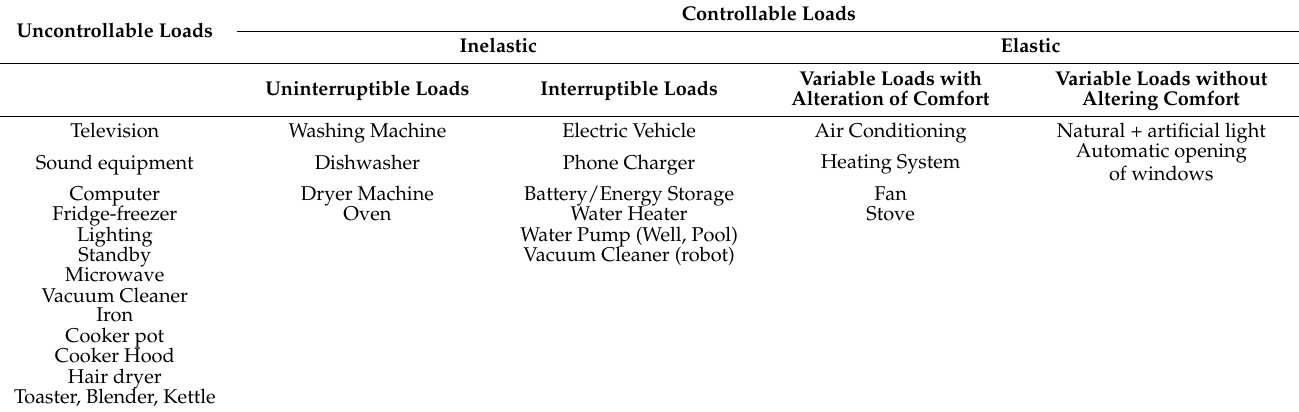
Table 1. Classification of the main household appliances according to their